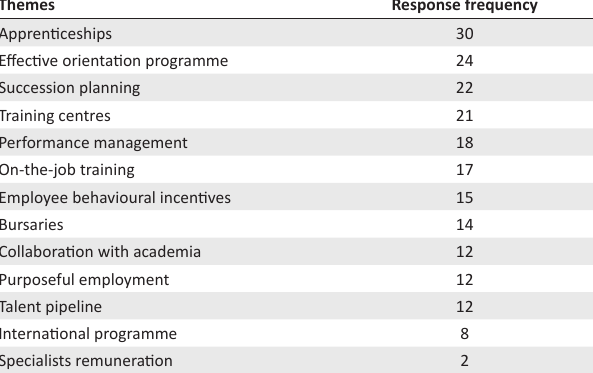
TABLE 9: Strategies used to repurpose talent in Industry 4.0 robotic organisations.